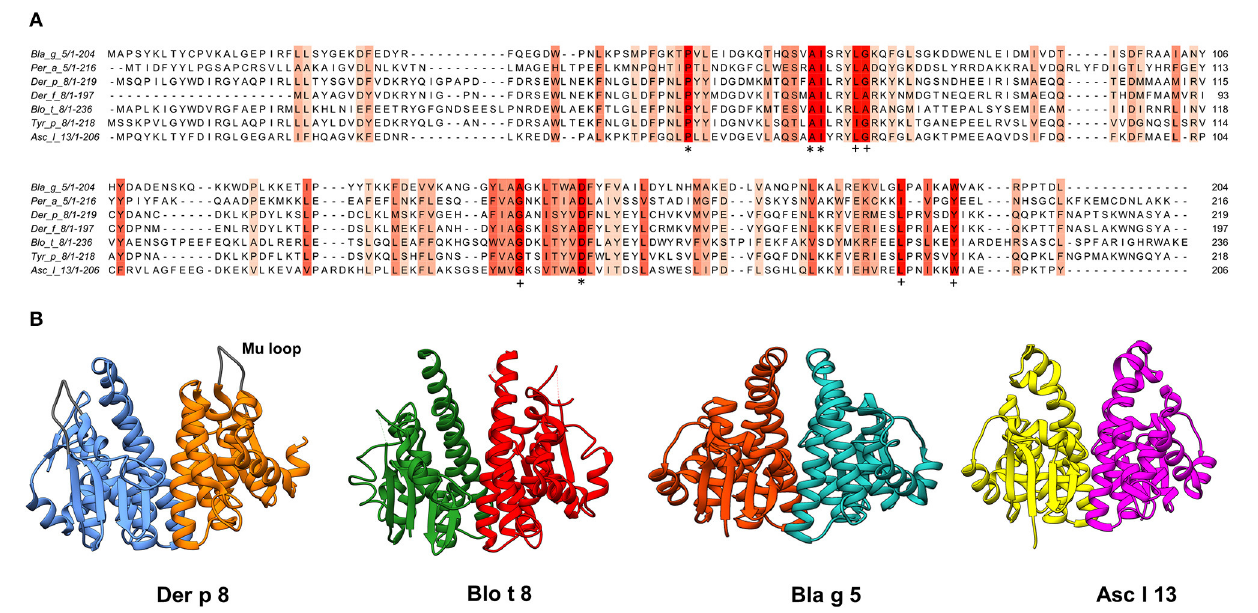
FIGURE 1 | (A) Multiple sequence alignments of reported GST Allergens. The most conserved columns have the most intense color, and the least conserved are the palest. A threshold score of 6 was used (conserved amino acids are those with six or more shared properties out of 10) ( 39). Columns with the same amino acids are marked with “*”, and columns with mutations where all properties are conserved are marked with “ + ”. AMAS method of multiple sequence alignment analysis was used to calculate the physicochemical properties conserved for each column (B) Ribbon diagrams of the structures of allergenic GSTs were generated in UCSF